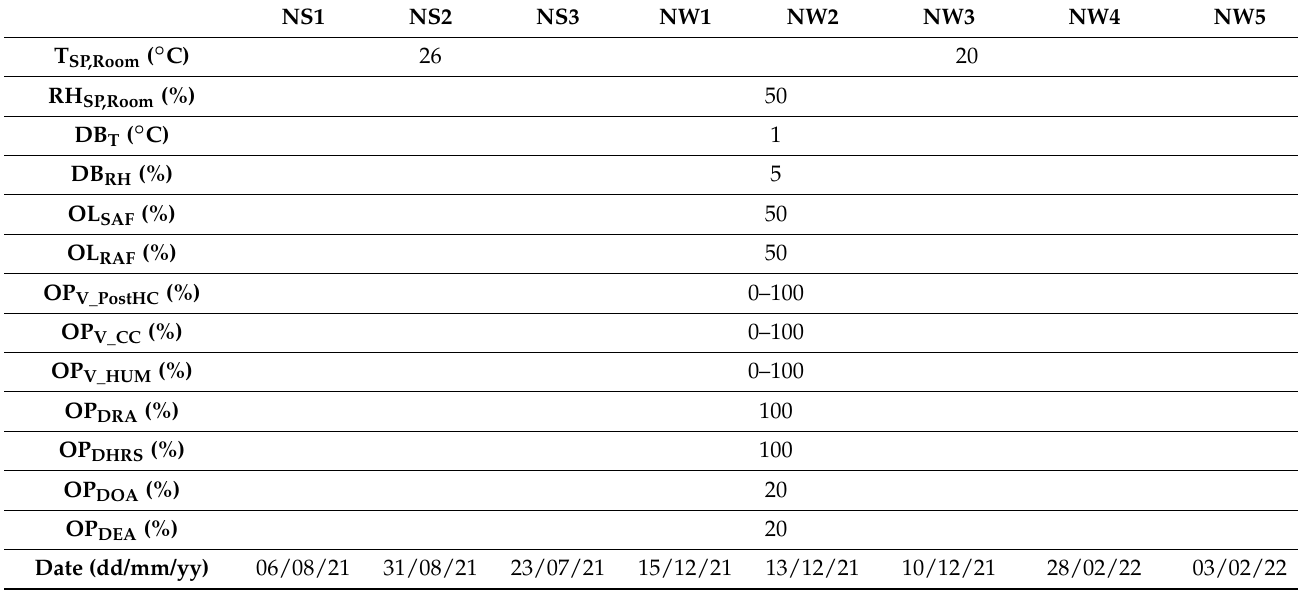
Table 5. Boundary conditions of the normal experiments.